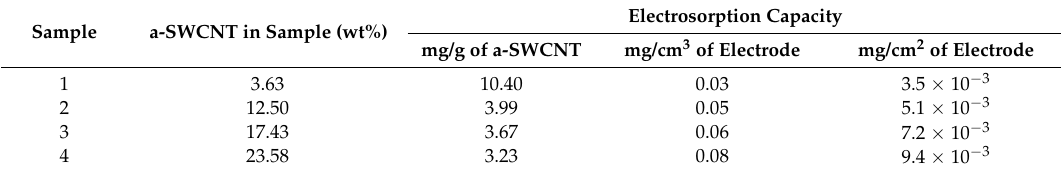
Table 3. Electrosorption capacity of different a-SWCNT/RVC composite